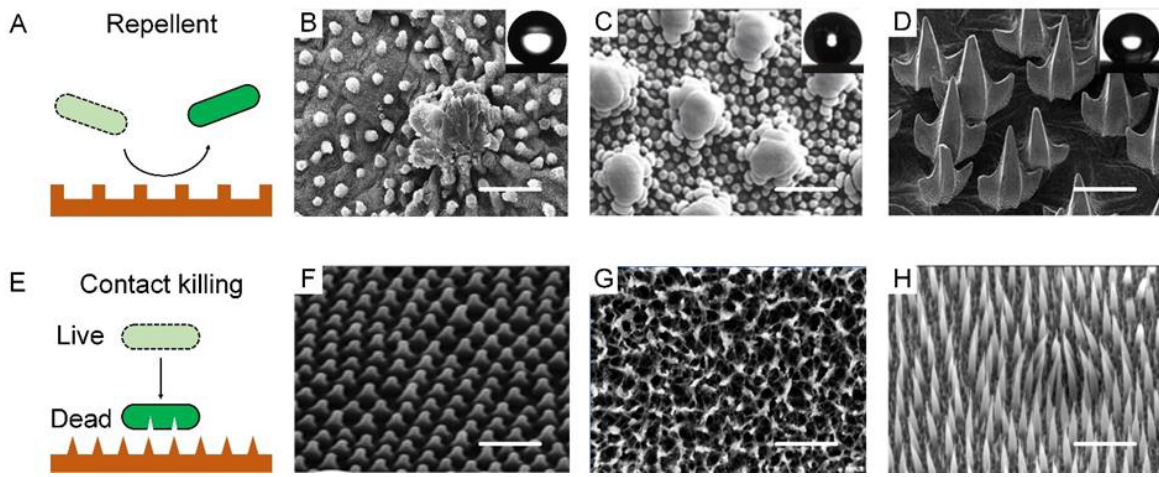
Figure 2. Nature bacteria-repellent surface and contact-killing surfaces. ( A ) Schematic diagram of natural bacteria-repellent surface. ( B ) Lotus leaves. SEM images showing “micropapilla” structures in lotus leaves. Scale bar: 50 µm. Reproduced with permission [54]. 2008, American Institute of Phys- ics (United States). ( C ) Springtail skin. SEM images showing “doubly - reentrant” structures in springtail skin. Scale bar: 2 µm. Reproduced with permission [34]. 2017, Wiley-VCH. ( D ) Sharkskin. SEM images showing “microdenticle” structures in sharkskin. Scale bar: 100 μm. Reprodu ced with permission [55]. 2019, Nature Portfolio. ( E ) Schematic diagram of natural contact-killing surface. ( F ) Cicada wings. SEM images showing “nanocone” structures in cicada wings. Scale bar: 2 μm. Repro- duced with permission [56]. 2012, Public Library of Science. ( G ) Dragonfly wings. SEM images showing “disordered nanopillar” structures in dragonfly wings. Scale bar: 200 nm. Reproduced with permission [49]. 2013, Nature Portfolio. ( H ) Lizard skin. SEM images showing “microspine” structures in lizard skin. Scale bar: 2.5 µm. Reproduced with permission [51]. 2017, Nature Portfolio.